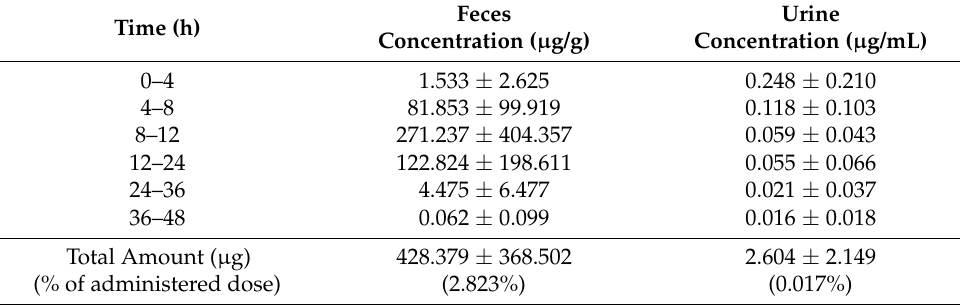
Table 4. Fecal and urinary excretion of erinacine A after oral administration of H. erinaceus mycelia